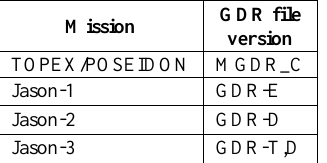
Table 1 . GDR file version names of TOPEX/Poseidon, Jason-1, Jason-2, and Jason-3.